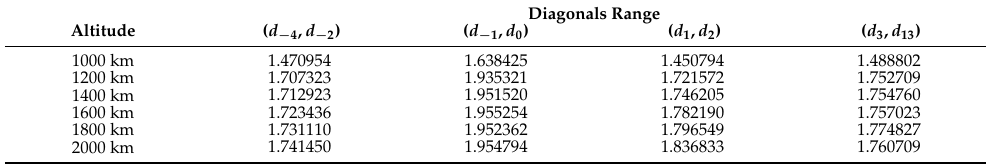
Table 6. Shape parameter, a , for matrix P a , using the diagonal notation as in (19), and as shown in Figure 9d.